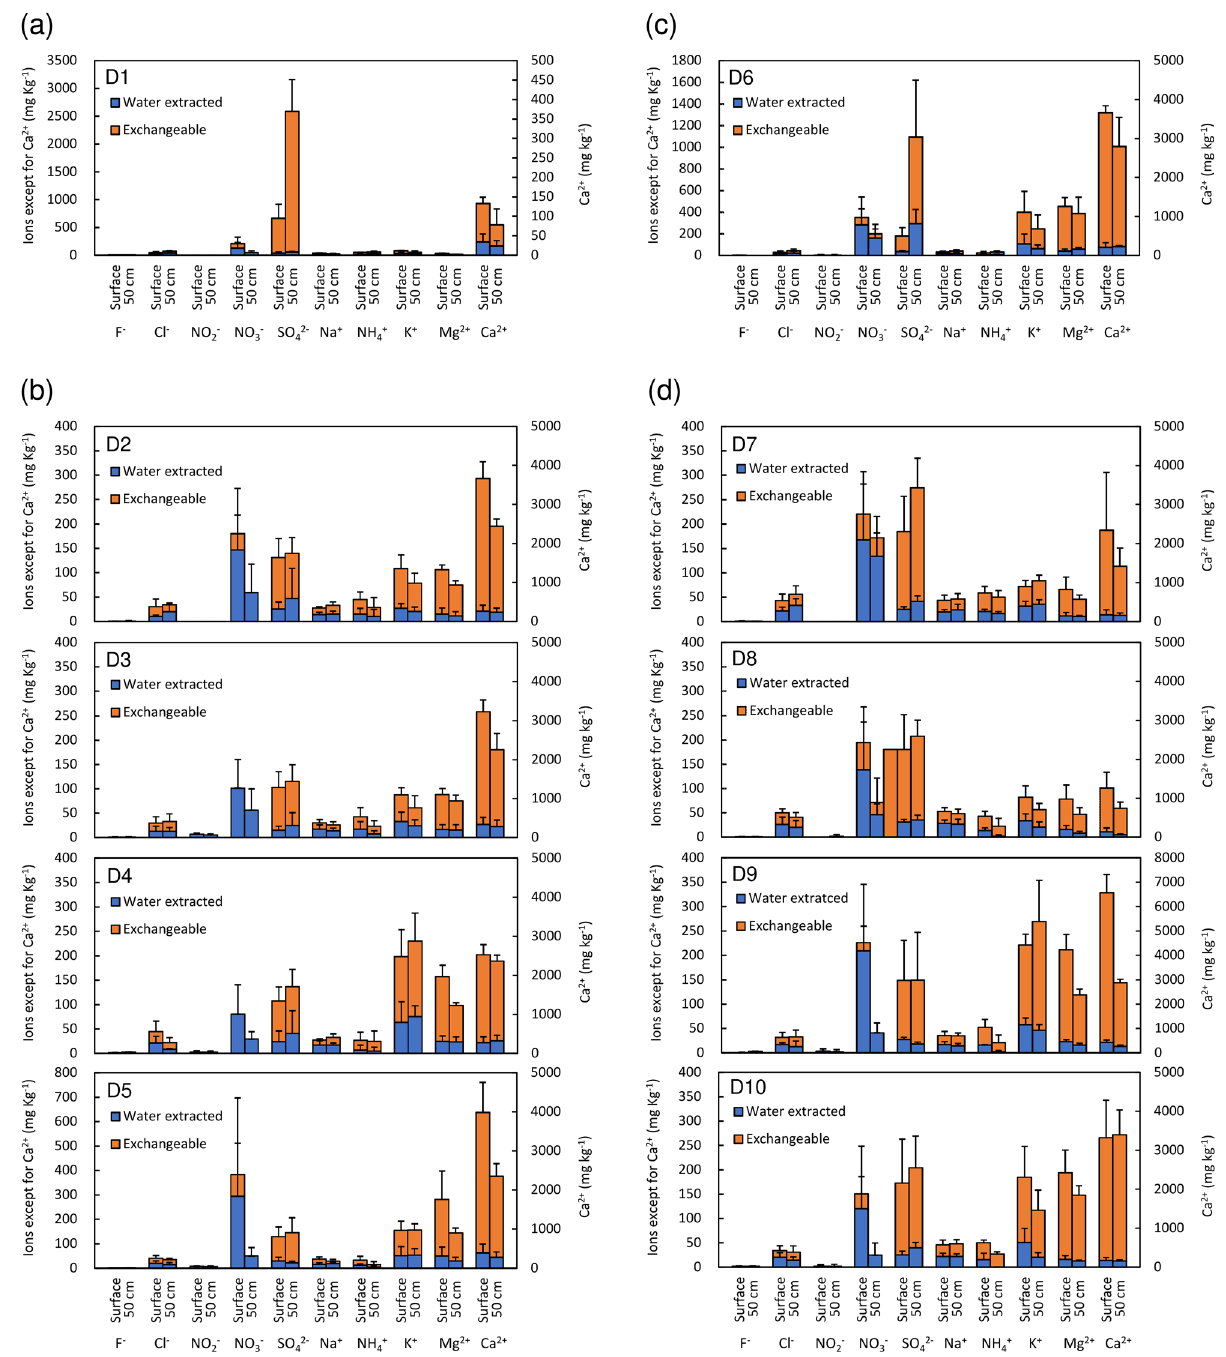
Figure 6. Major ion components in different soil types ( a ) forest, ( b ) LWDS, ( c ) upland field, and ( d ) Nishikawa River